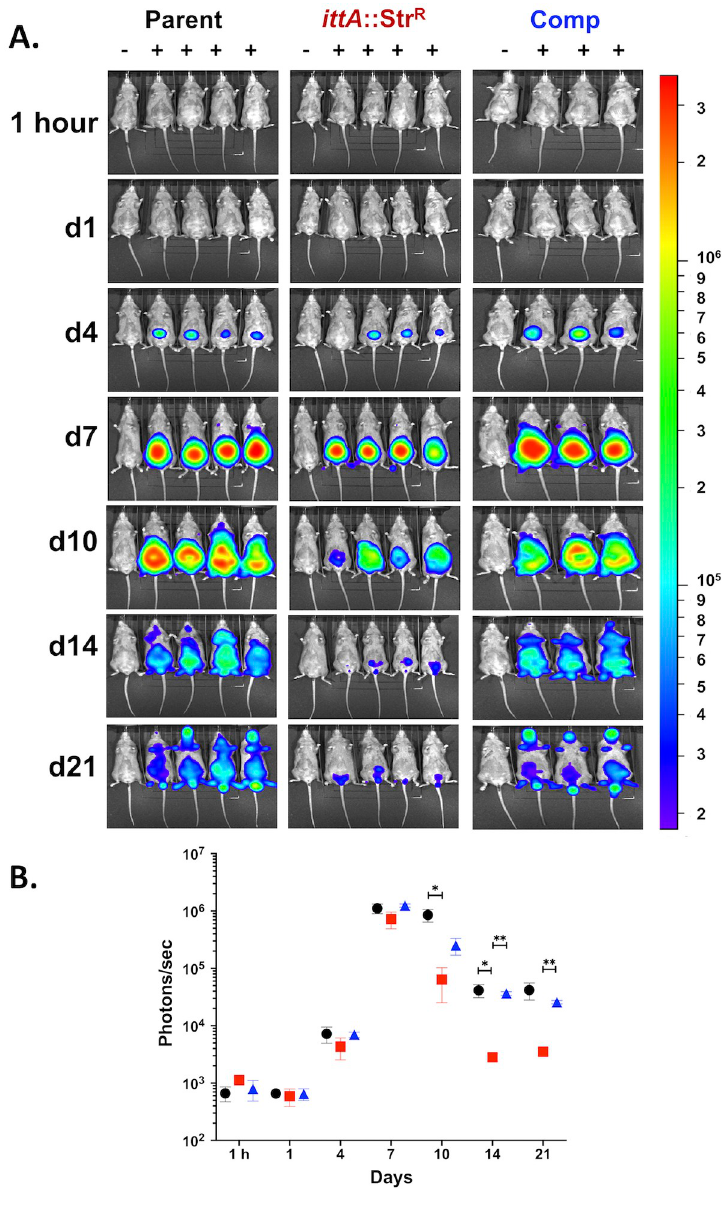
Fig 4. Spatial and temporal infectivity analysis of the ittA mutant. A. The course of infection of bioluminescent B . burgdorferi strains was tracked following the infection of C3H/HeN mice with 10 3 of each B . burgdorferi isolate. Mice were infected for 21 days total with the parent (n = 5), ittA sRNA mutant (n = 5), and the ittA genetic complement (n = 4) and imaged on the time or day (d) listed on the left. For each image shown, the mouse on the far left (denoted with a ‘ − ’) was infected with B . burgdorferi but did not receive D-luciferin to serve as a background control. Mice denoted with a ‘+’ were infected with the strain indicated and treated with D-luciferin to promote light emission. All images were normalized to the same scale (in photons/sec; shown on the right). B. Quantification of in vivo luminescence images of mice infected at a dose of 10 3 of B . burgdorferi . Parent strain ML23/pBBE22 luc is depicted as black circles, the ittA sRNA mutant DM103/pBBE22 luc as red squares, and the genetic complement strain DM113/ pBBE22 luc as blue triangles. Each time point represents the average value and the standard error from the four mice given D-luciferin substrate for the parent and sRNA mutant strains and three mice for the complement strain. � p < 0.05; �� p <